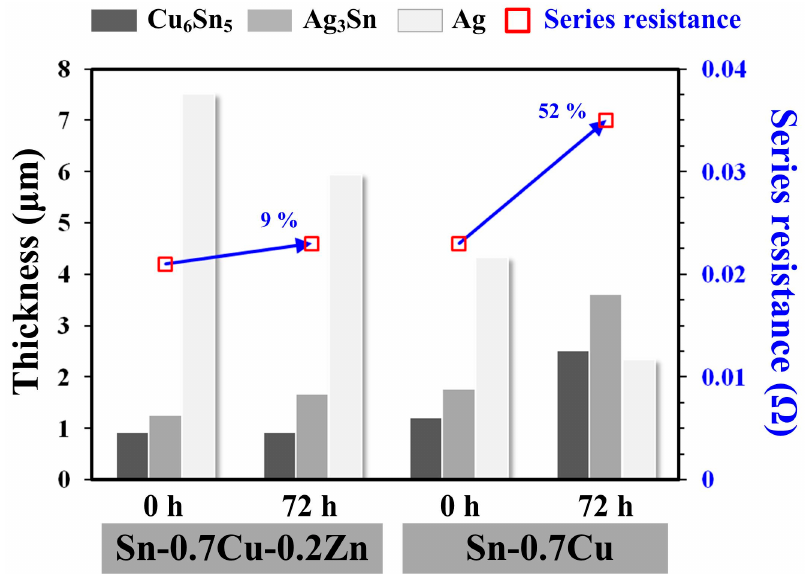
Figure 5. Series resistances of Sn–0.7Cu–0.2Zn and Sn–0.7Cu PV modules as a function of IMCs thickness and bias duration.